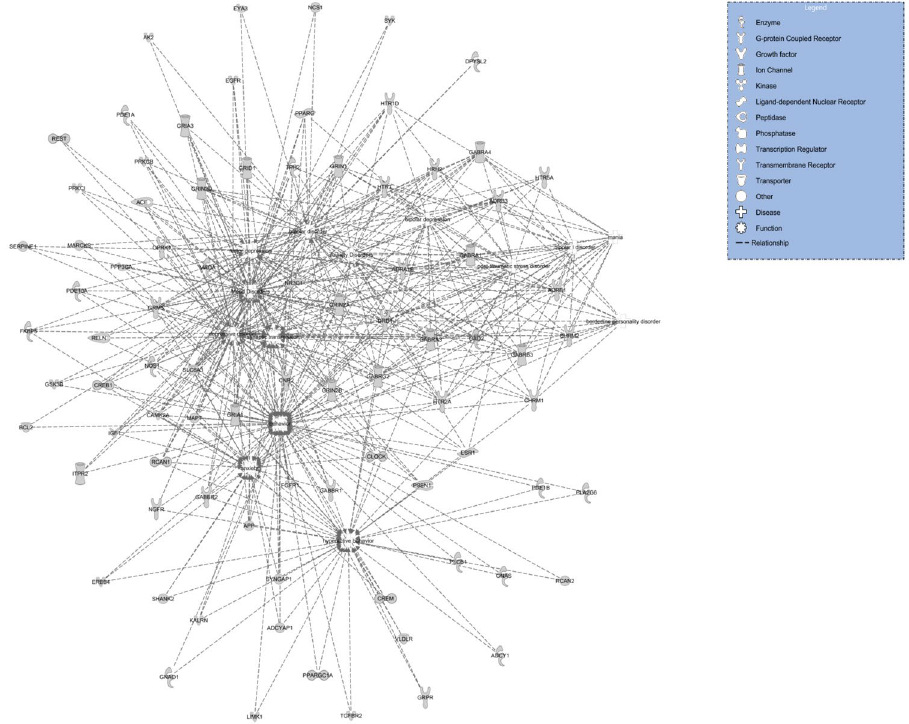
Figure 7. Enriched gene regulatory network of altered miRNAs and their targets with functional relationship to neuropsychiatric disorders. Overlapping target gene network affected by altered miRNAs were mapped. Representing hubs on the network were pathophysiological footprints of associated neuropsychiatric disorders. (p < 0.05, Fisher’s Exact